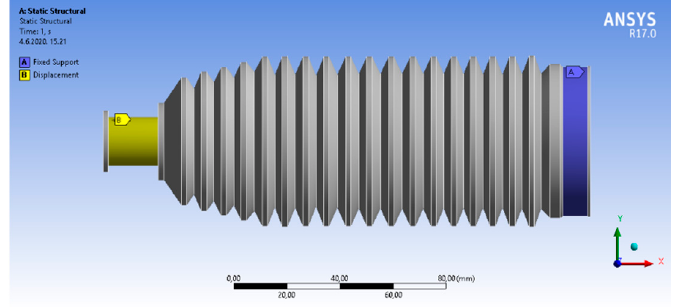
Figure 9. The cuff’s boundary conditions. Figure 9. The cu ff ’s boundary